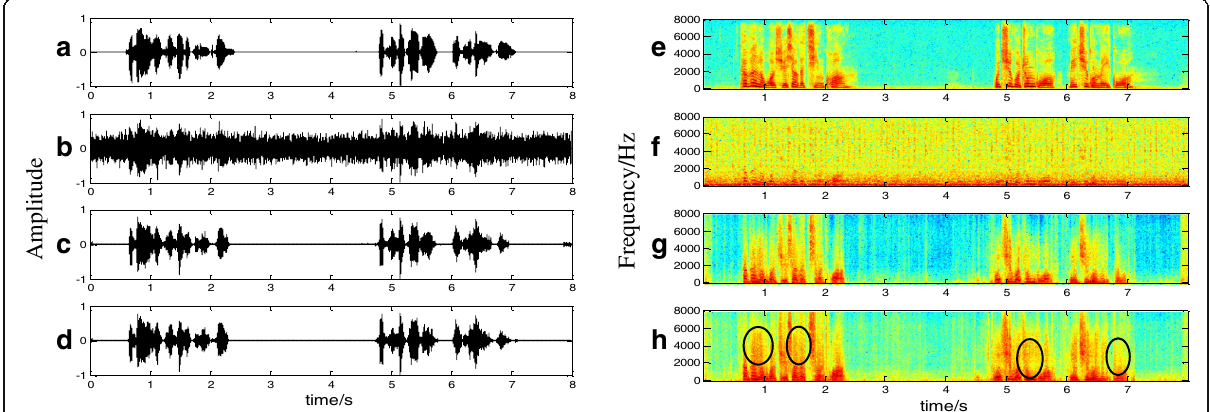
Fig. 3 Results sample of speech enhancement based on MRCG and MRACC features. a Waveform of clean speech. b Waveform of noisy speech. c Waveform of enhanced speech with MRCG. d Waveform of enhanced speech with MRACC. e Spectrogram of clean speech. f Spectrogram of noisy speech. g Spectrogram of enhanced speech with MRCG. h Spectrogram of enhanced speech with MRACC